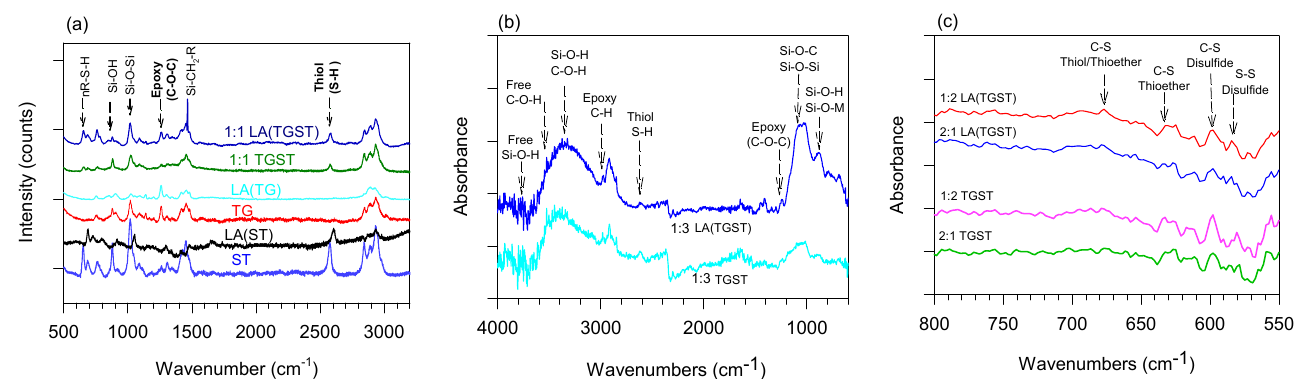
Figure 1. Structural characterization of the precursor formulations LA(TG) and LA(ST) and the hybrid LA(TGST) formulations by Raman ( a ) and Fourier Transform Infrared (FTIR) spectroscopy ( b , c ) contrasted with the TG, ST and the TGST hybrids.